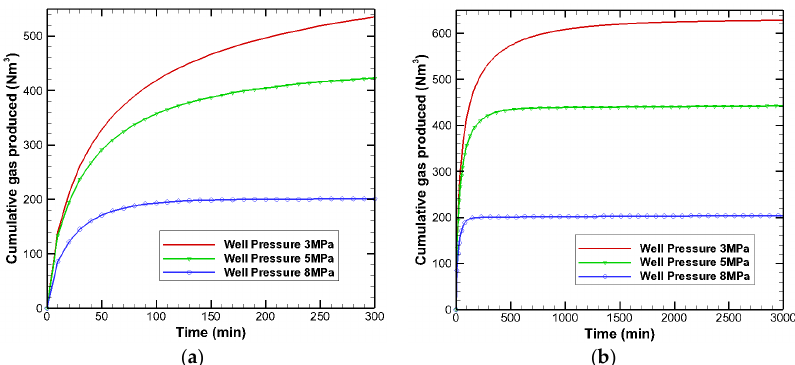
Figure 7. Comparisons of cumulative gas produced under well pressure of 3 MPa and different initial temperatures (274 K, 279 K, and 284 K) at different exploiting time ( a ) 300 min; ( b ) 3000 min.